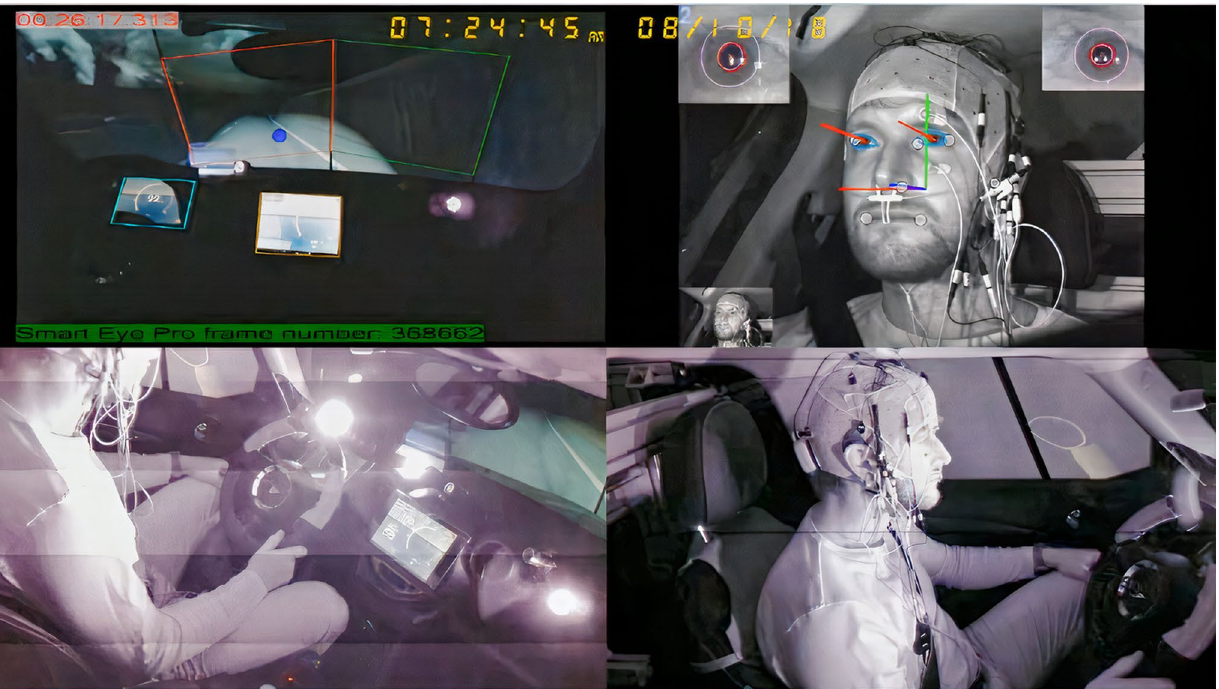
Figure 1. Four different views of the driver when he was conducting the test. The test road in a night drive and a dashboard instrument that shows the velocity of the vehicle in the simulated test track are shown in the left part. The output of the eye-tracking system that detects the eyelid movements and pupil diameter is presented in the right upper part (Reprinted from our previous study 14 ; Copyright (2021), with permission from Elsevier, License No. 5058681457961. Informed consent was obtained from the driver to publish his